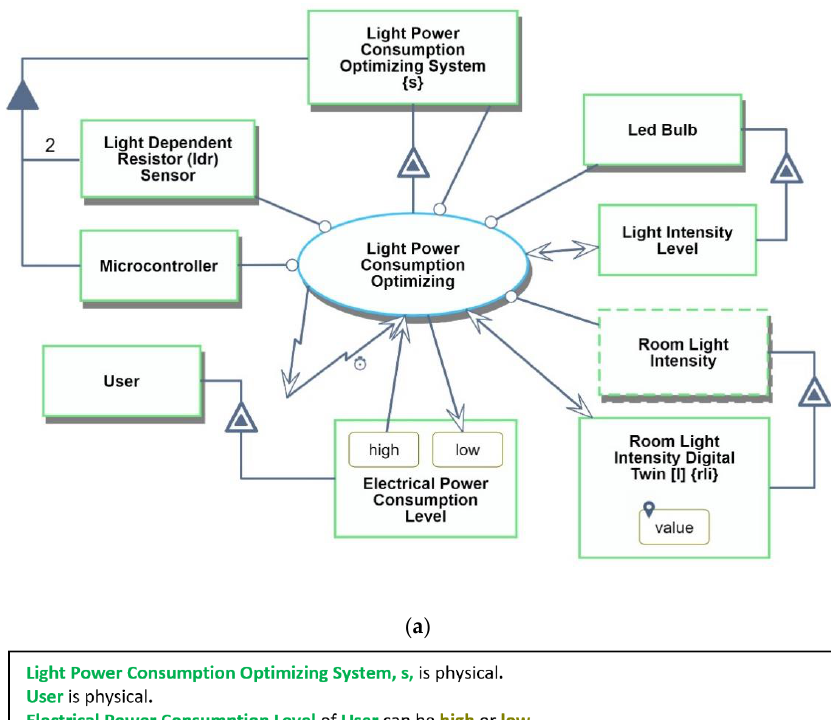
Figure 16. SD1, in which Light Power Consumption Optimizing is zoomed into. 5.3. Adding the Stereotypes to the Model We now enhance our model example with the predefined OPM stereotypes. To simplify the example, we consider only the IoT system cost and power consumption. Once some OPD in the model is updated with the stereotyped objects, they automatically propagate to all the model OPDs.